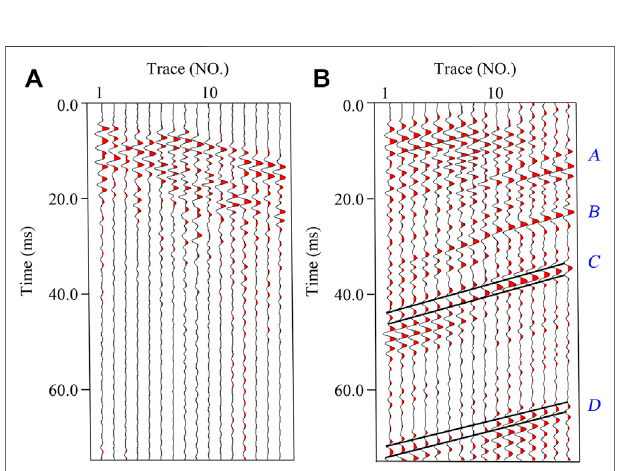
FIGURE 11 | Original and preprocessed seismic record. Two events marked by black lines in (B) are selected as calculation signals of PMVMB method.